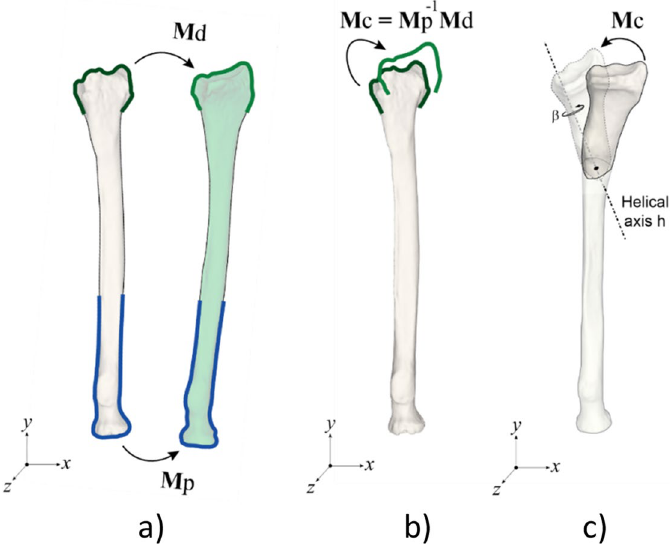
Figure 2. ( a ) Registration of a distal and proximal segment to a target bone yield M d and M p from which the correction matrix ( b ) can be calculated. ( c ) An oblique single-cut rotation osteotomy (OSCRO) achieves alignment by rotation β of the distal segment about the helical axis h . The cutting plane is chosen perpendicular to this helical